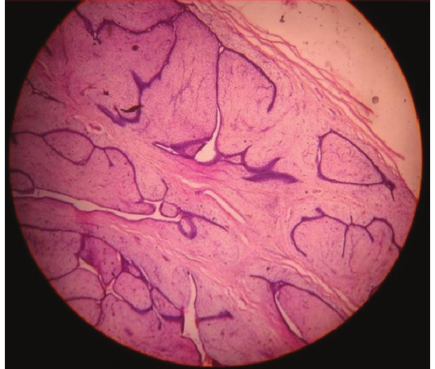
Figure 4: Microscopic picture of the specimen